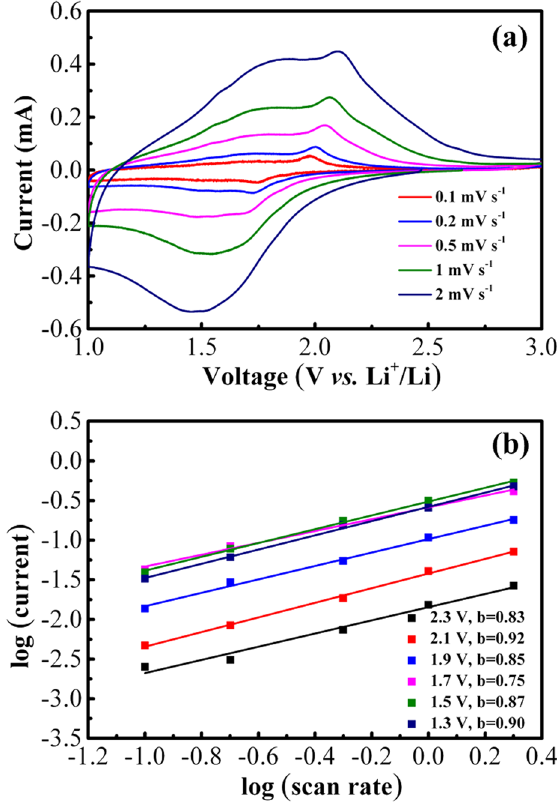
Figure 7. ( a ) CV curves of TiO 2 @Nb 2 O 5 composites with different scan rates and ( b ) their corresponding log (current) vs log (scan rate) fitting lines.